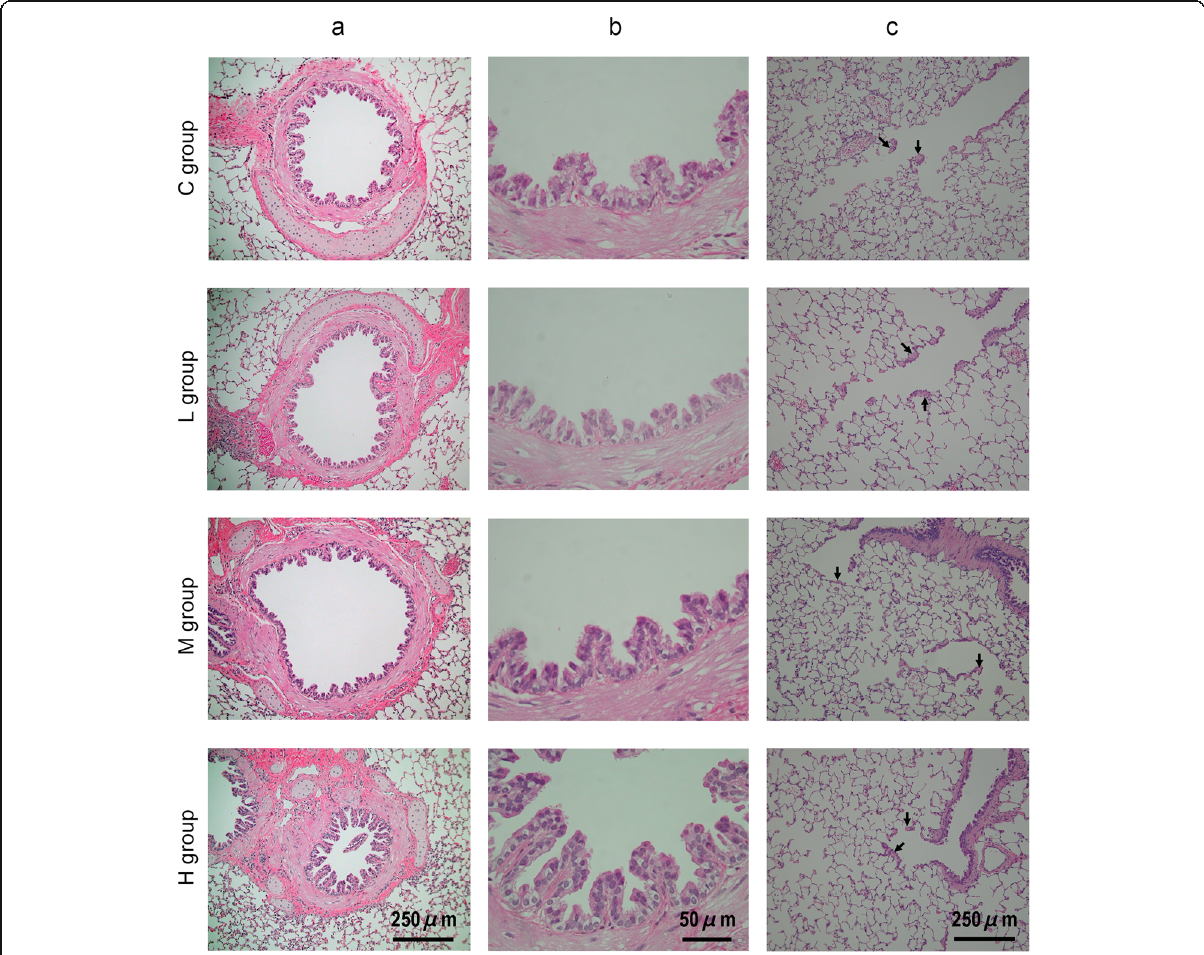
Fig. 2 Effect of HONO exposure on the respiratory tract observed under light microscopy using hematoxylin and eosin staining. a , b Main bronchus near the middle of right-lung middle lobe. c Alveolar duct regions. Arrows indicate smooth muscle cells in the interstitium of the alveolar duct regions